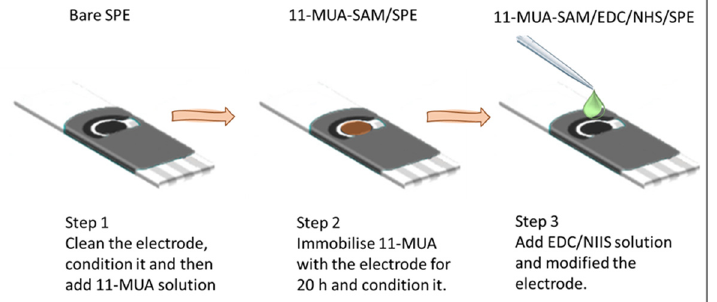
Figure 3. The steps involved in the formation of self-assembled monolayers on the gold electrode.